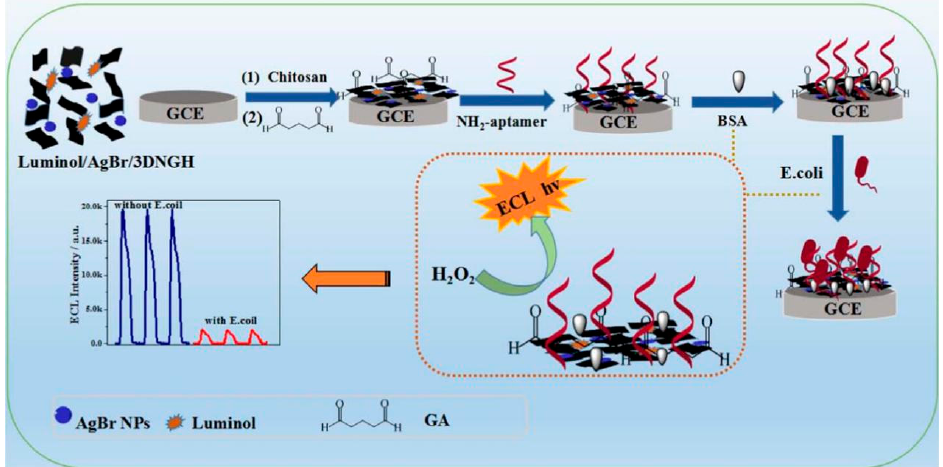
Figure 3. Schematic of ECL aptasensors based on AgBr nanoparticles (NPs) anchored 3D nitrogen doped graphene hydrogel (3DNGH) nanocomposites for E. coli detection. Reproduced with permission from [65], published by Elsevier B.V, 2017.